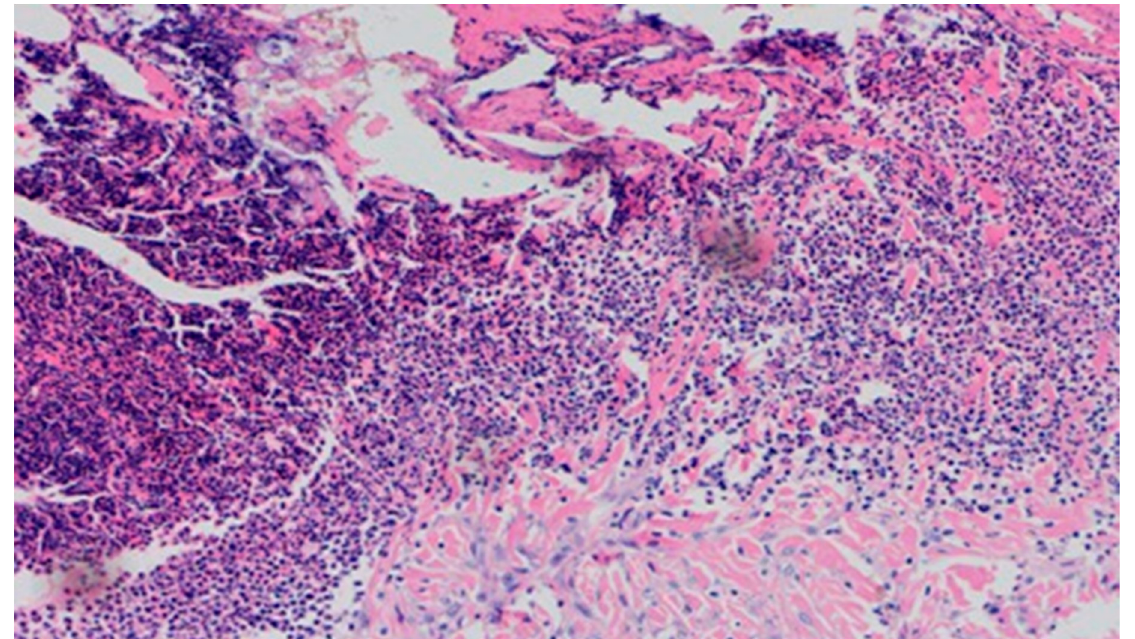
Figure 18. Dermis with high-density granulocytic inflammatory infiltration (100×, H-E) in the sulfathiazole-treated wound on day 15.